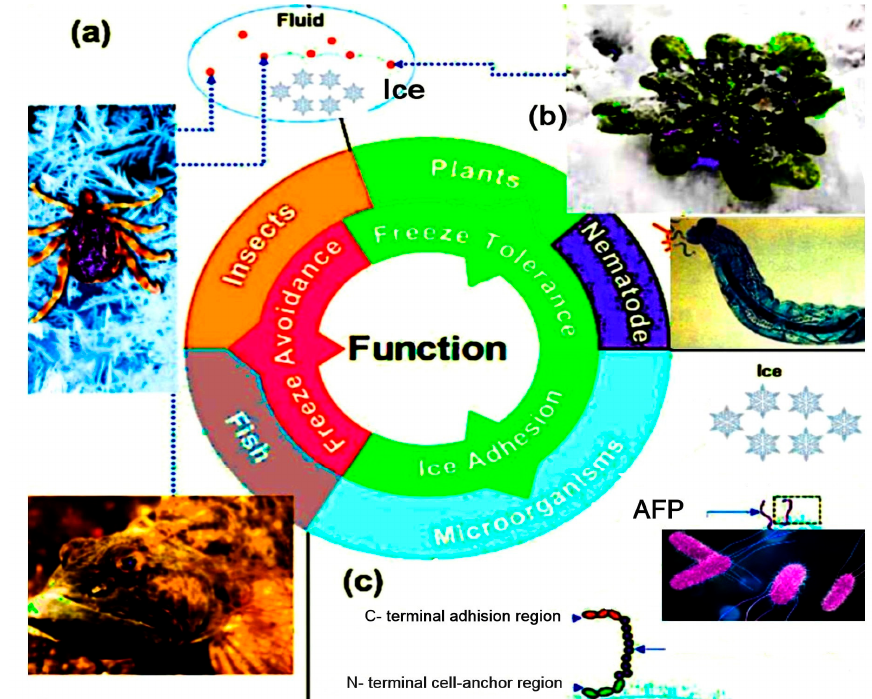
Figure 1. The natural properties of antifreeze proteins (AFPs) (thermal hysteresis and ice recrystallization inhibition) in various organisms in nature. ( a ) For freezing inhibition, AFPs can block forming of ice crystals in fish and insects by lowering down the freezing points in body fluids. ( b ) In plants and nematode, freeze-tolerating is carried out by binding the AFPs to the surface of ice and prevent it from becoming larger ice crystals. ( c ) AFPs of different microorganisms can adhere to the ice surface, like Marinomonas primoryensis, and inhibit the formation of ice crystals. Adhesion of AFPs to ice can be done from three regions: C terminal, N terminal, and intermediate repeat [10].